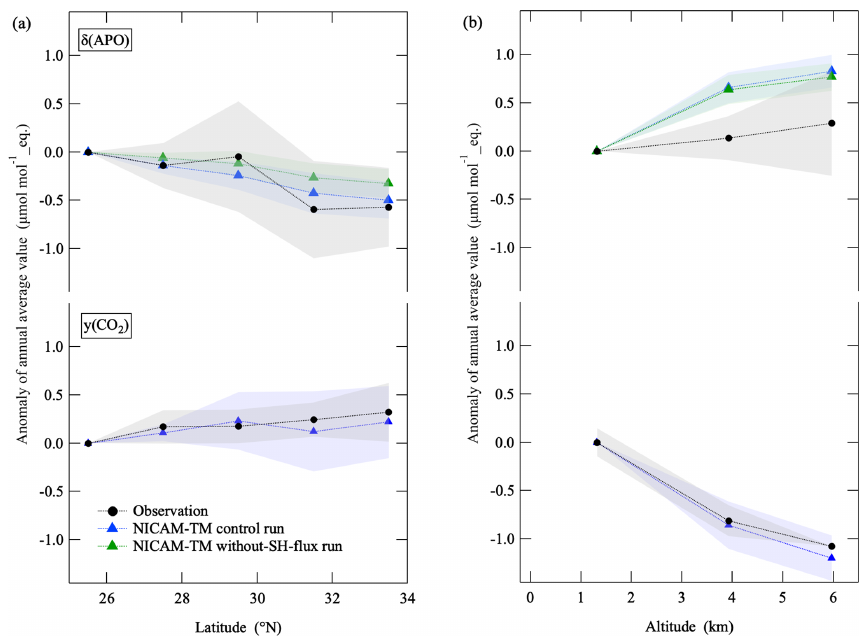
Figure 9. (a) Latitudinal distribution of average deviations of the annual mean values of δ (APO) and the CO 2 amount fraction relative to those at 25.5 ◦ N in the troposphere over the western North Pacific throughout the observation period (black filled circles). Error bands (shaded) indicate year-to-year variations ( ± 1 σ ). The corresponding results calculated using NICAM-TM for the control run (blue triangles) and the without-SH-flux run (green triangles) are also shown. (b) Same as in (a) but for vertical distribution over MNM relative to the corresponding values at